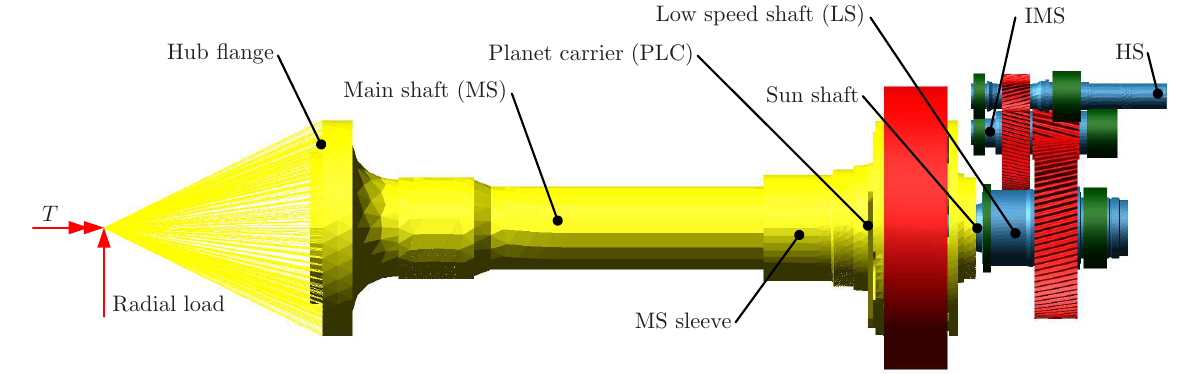
Figure 1: Naming of the main components.